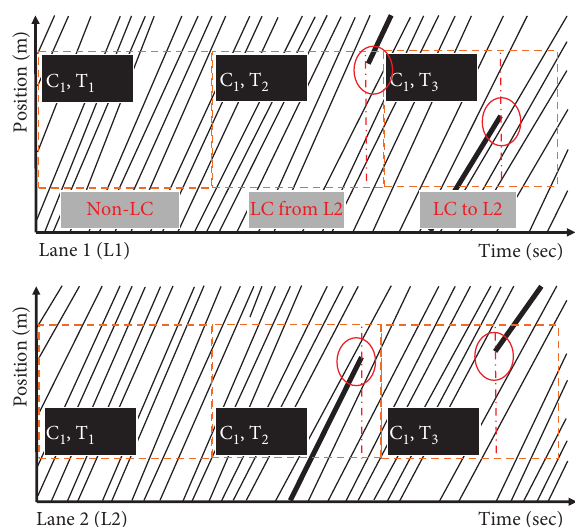
Figure 2: Observation of the occurrence of lane change vehicles and the relevant information using vehicle trajectory for the preparation of data towards modeling lane change